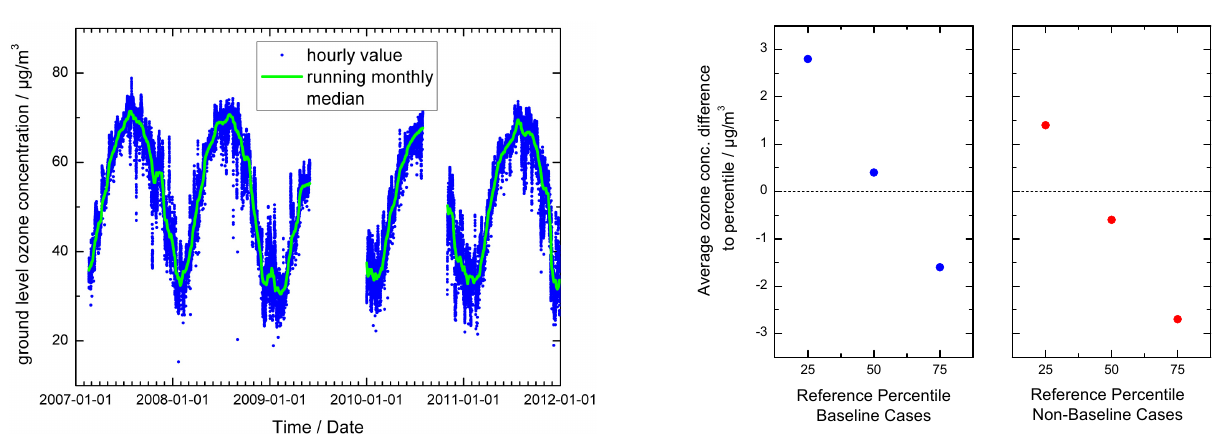
Fig. 6. Time series of atmospheric ground-level ozone concentra- tion (hourly averages) at Troll in the time period 2007–2011. Also plotted is the running 4-week median (green line) to extract the an- nual cycle in the ozone concentration.